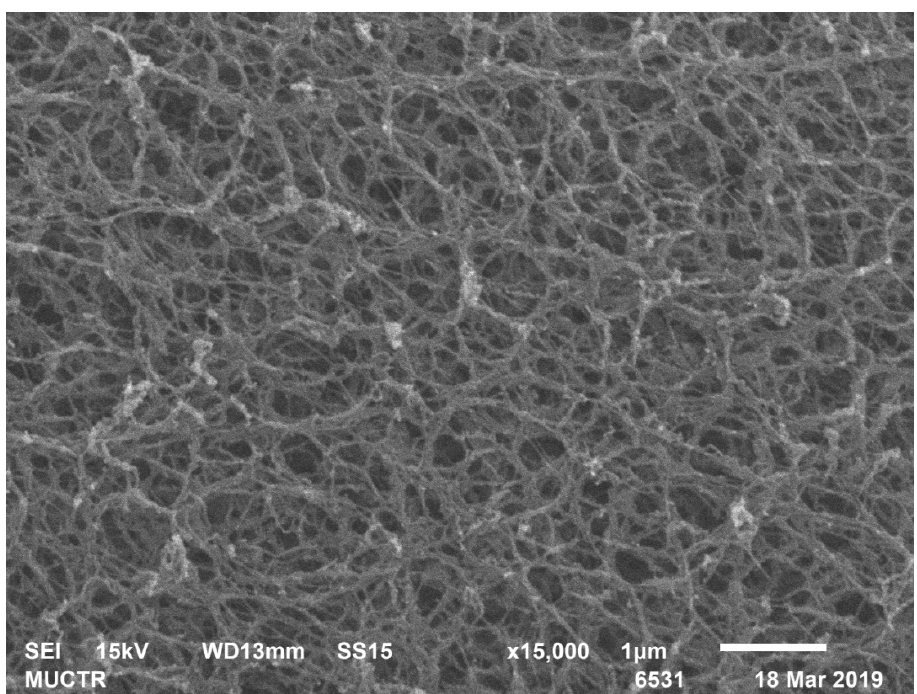
Figure 8. SEM-image of sample 11 chitosan-based aerogel particles.